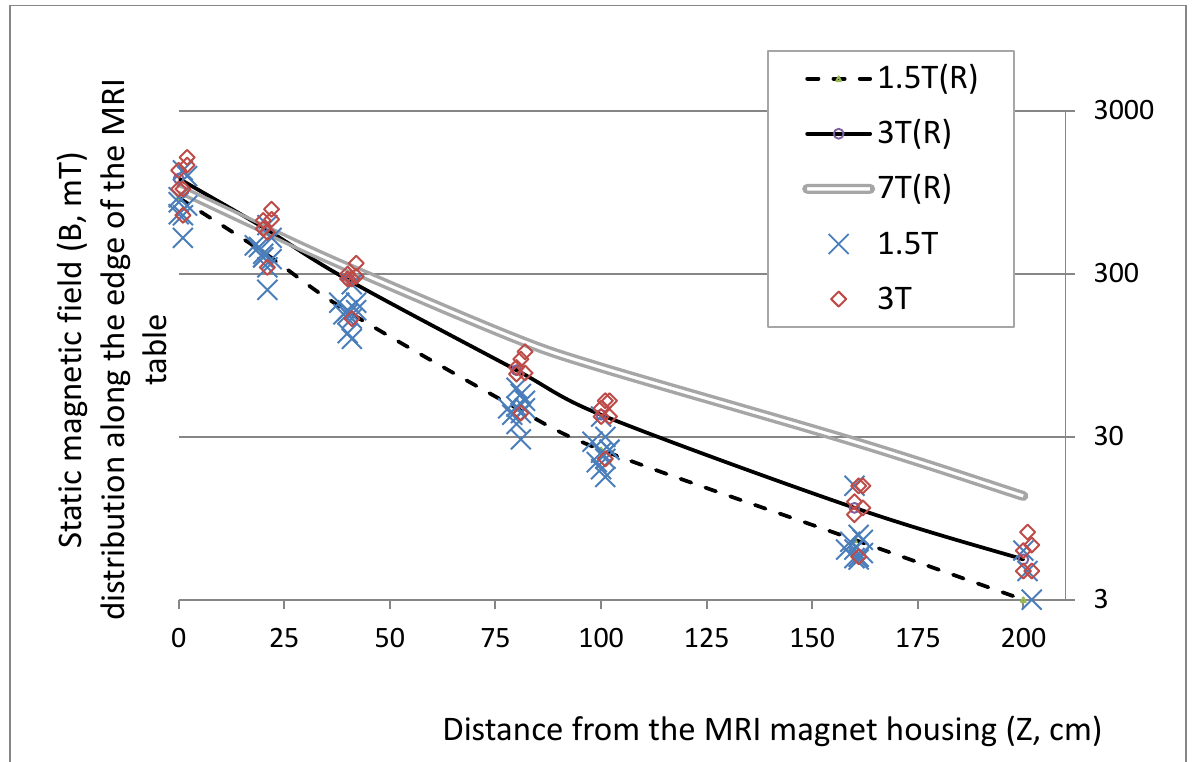
Figure 2. Plot of static magnetic field distribution along the edge of the MRI table, derived from the results of spot measurements of magnetic flux density (B, in mT) near 16 whole-body, closed-bore, horizontal-field, MRI magnets (symbols represent data regarding individual magnets, and lines represent results averaged over groups of magnets: 10 MF-MRI (1.5T) magnets, five HF-MRI (3T) magnets and one UHF-MRI (7T) magnet). Note to editors: please find copies of all figures in enclosed files, please keep the caption together with a figure on the same page.